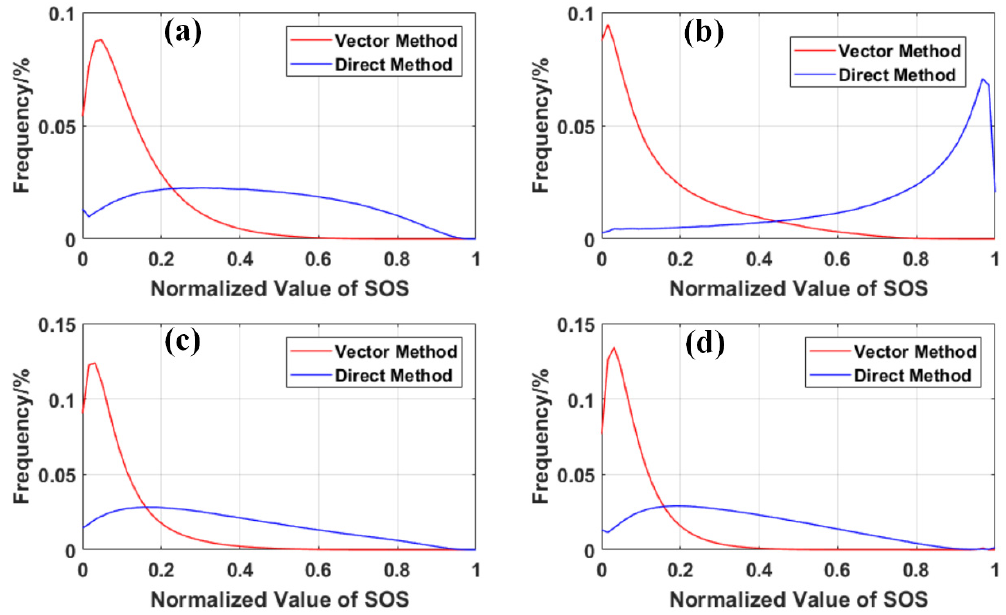
Figure 10. Frequency distribution of SoS using different methods in different areas. ( a ) Suide TA1, ( b ) Suide TA2, ( c ) Mount Lu, and ( d ) Dahua.